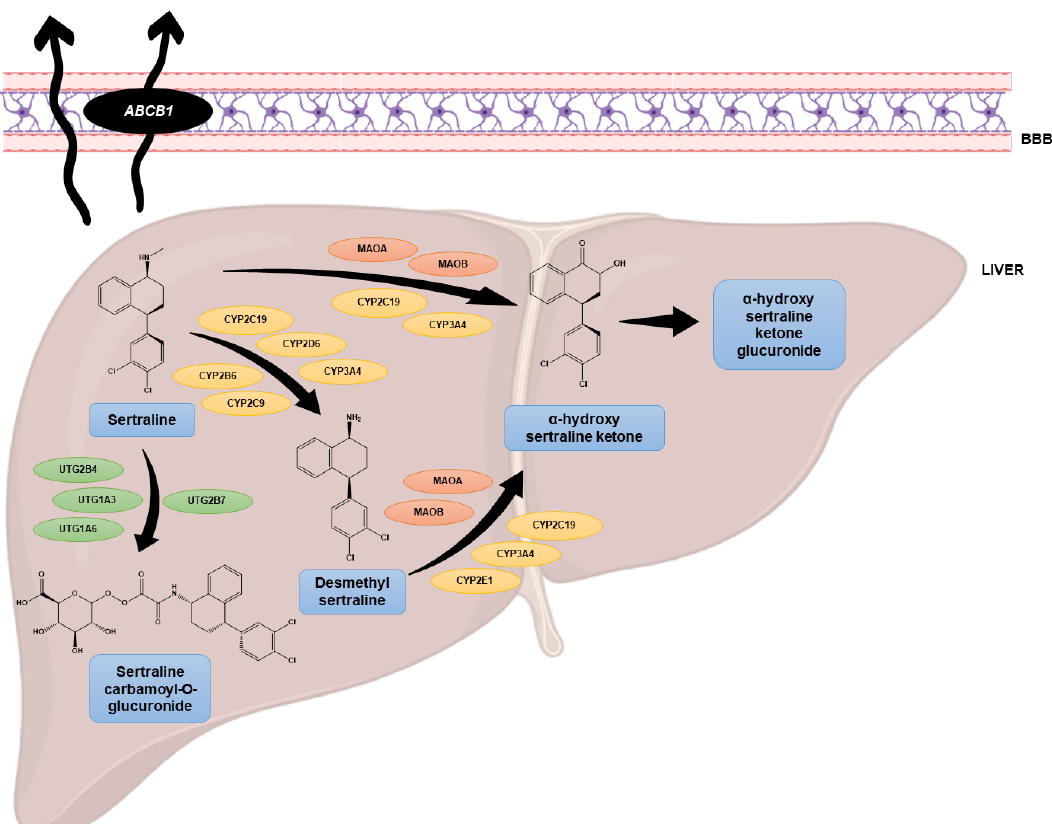
Figure 2. Metabolism of sertraline in the liver and its interaction with the BBB. Adapted from [28].